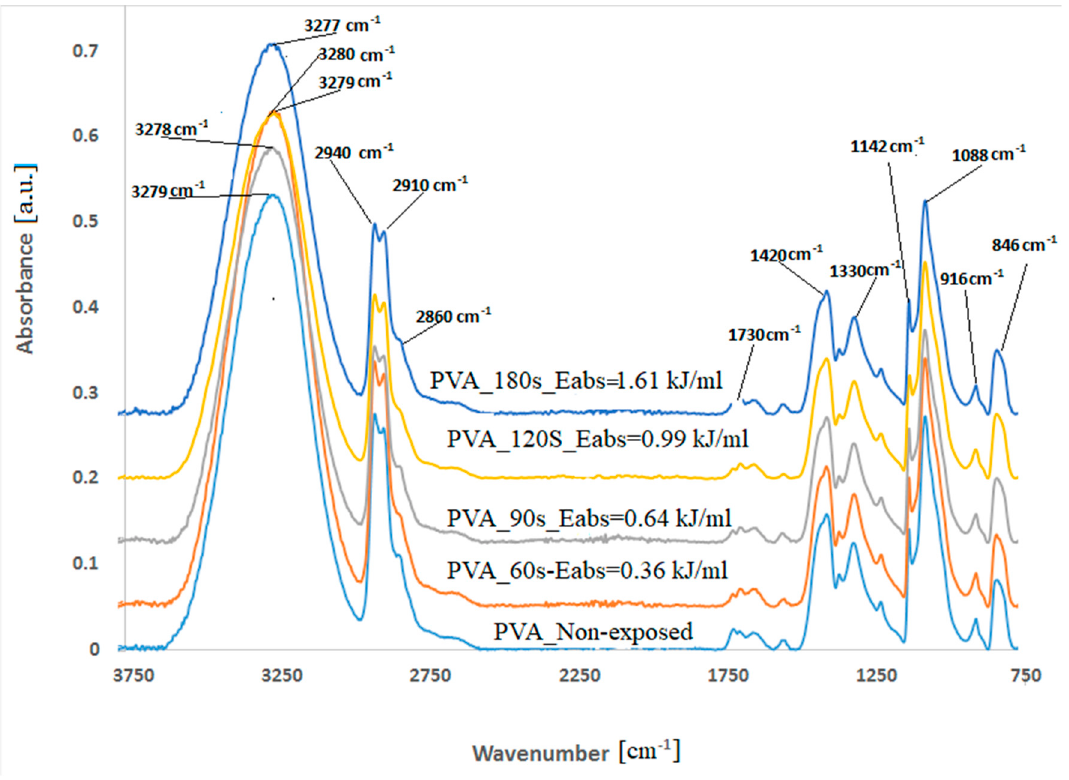
Figure 2. FTIR spectra of the obtained foils from the non-exposed and post-MW exposure PVA